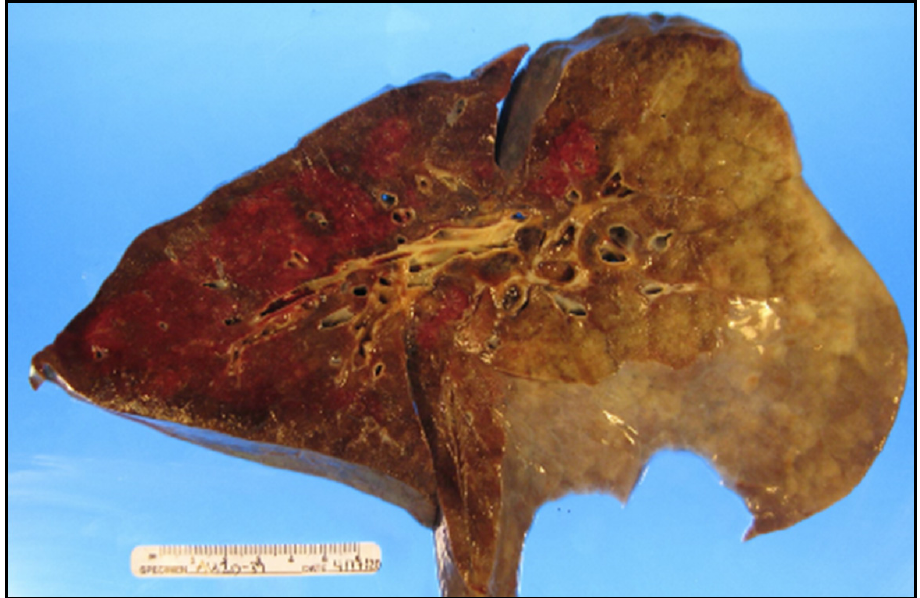
Figure 1. A heavy lung from a deceased COVID-19 patient with patchy consolidation and hemorrhage. Figure courtesy of Dr. Sharon Mount from the University of Vermont Medical Center.